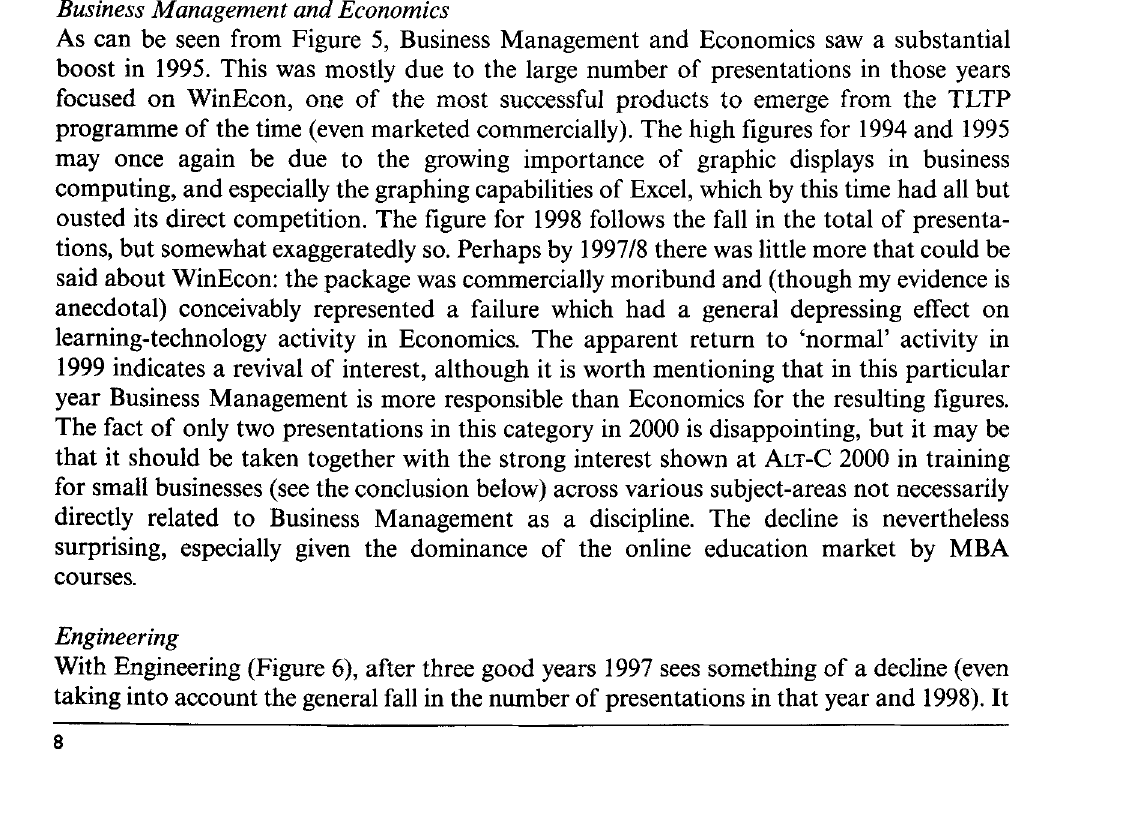
Figure 5: Data for Business Management and